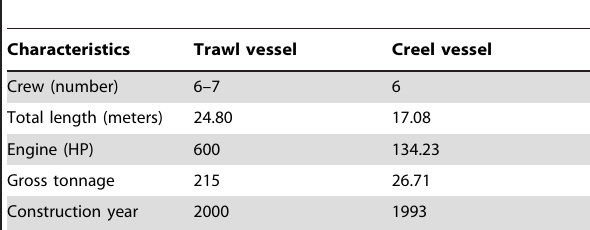
Table 2. Technical characteristics of the vessels